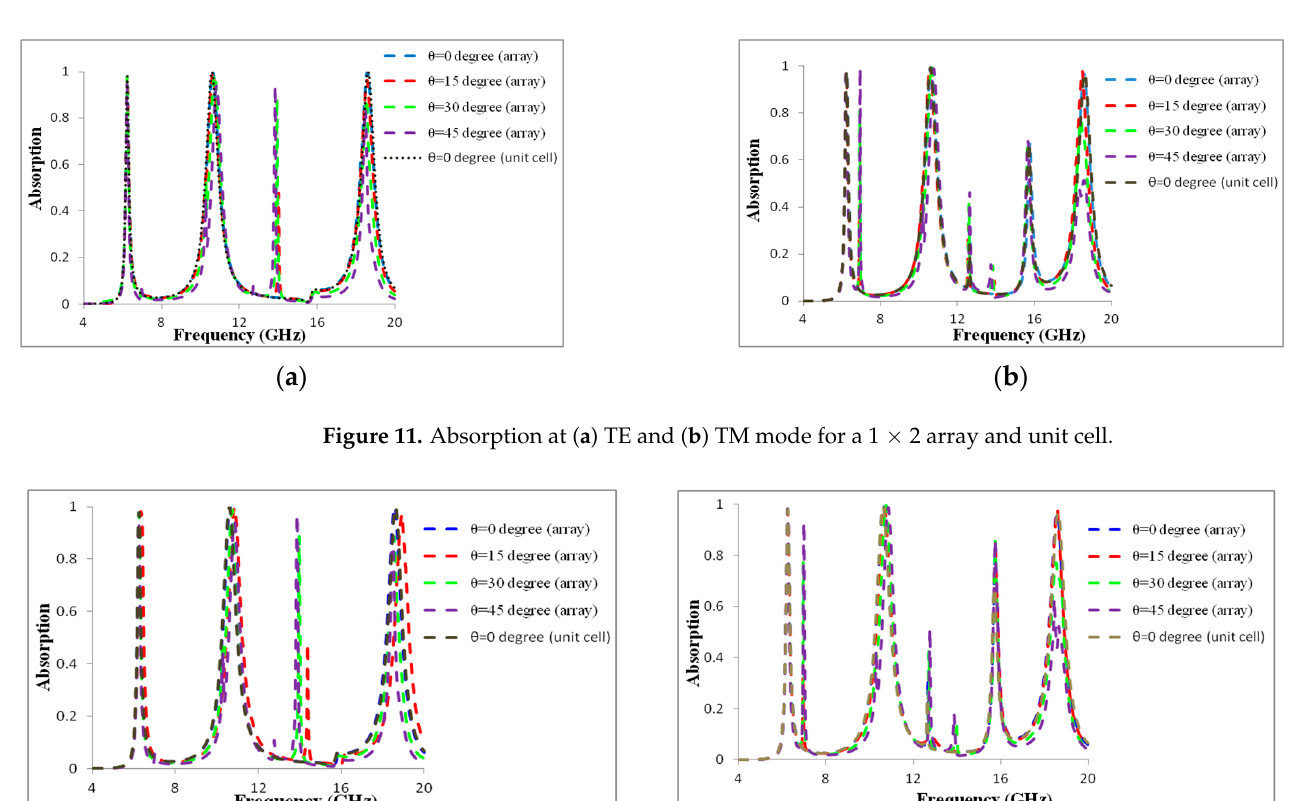
( b ) Figure 10. The scenarios of ( a ) permittivity and ( b ) permeability. 3.6. Array Analysis The numerical performance was calculated for initial arrays of 1 × 2 and 2 × 2 sets of